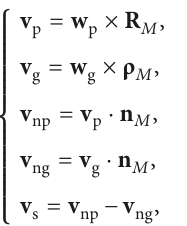
Figure 9: Sketch map of meshing-in impact (on end face): (a) shock velocity principle, (b) dynamic model of meshing-in meshing line, ignoring the manufacturing errors and the deformation of tooth; M is the actual original position of the meshing-in contact; M 1 M 2 is the instantaneous meshing line through point M ; v p and v g are the tangential speeds of the pinion and gear; v np and v ng are the normal speeds of the pinion and gear; r bp and r bg are the theoretical base radii of the pinion and gear; and r ′